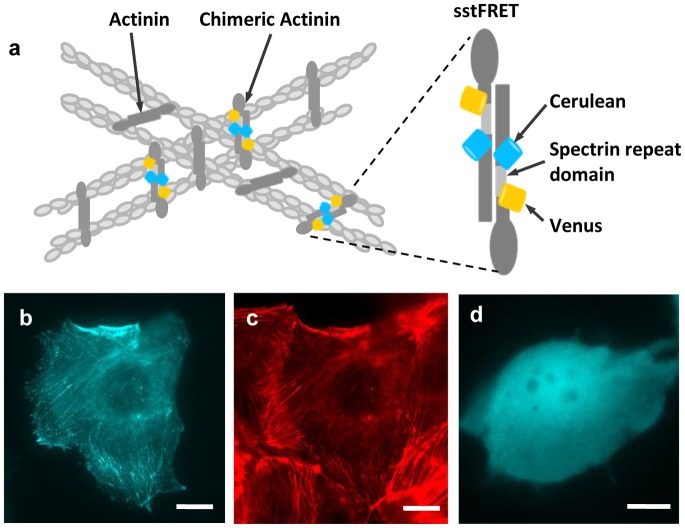
Actinin-sstFRET sensor construction and expression in MDCK cells.
a: Schematic of actinin-sstFRET sensors inserted in actin cytoskeleton. The sensor consists of Cerulean as donor, Venus as acceptor, and a linker (spectrin repeat domain), and is inserted close to the middle of actinin. b: Fluorescence image of actinin-sstFRET in MDCK cells. c: Fluorescence image of F-actin stained with phalloidin-Alexa Fluor 568, showing co-localization of actinin-sstFRET with actin. d: Fluorescence image of MDCK cells expressing free sstFRET, showing uniformly distributed fluorescence molecules in cytosol. The scale bars represent 10 µm.